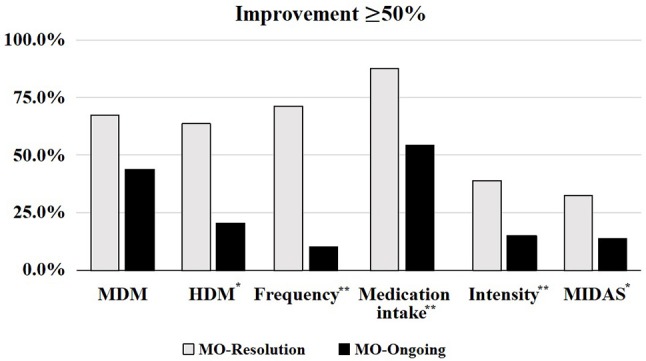
Fifty percent positive response to onabotulinumtoxinA in regards to MO resolution. MDM, Migraine days/month; HDM, Headache days/month; Frequency, headache frequency; MIDAS, Migraine Disability Assessement score; MO, medication overuse. *p < 0.05, **p < 0.001.